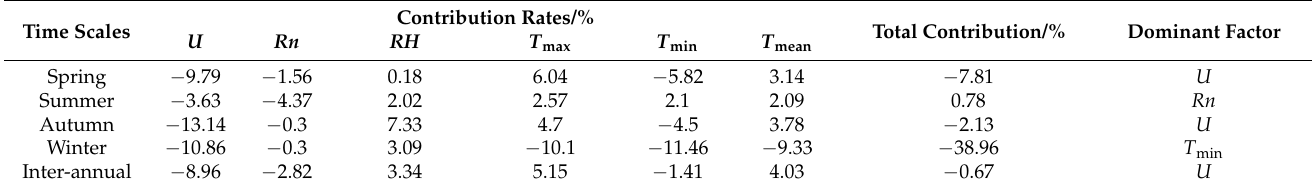
Table 3. Contribution of seasonal and inter-annual climate factors to ET 0 changes from 1960 to